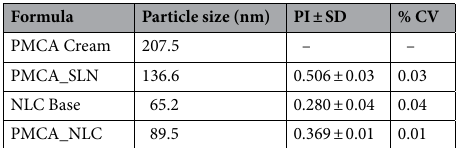
Table 1. Particle size and polydispersity index (PI) of PMCA cream, PMCA_SLN, NLC base, and PMCA_ NLC.